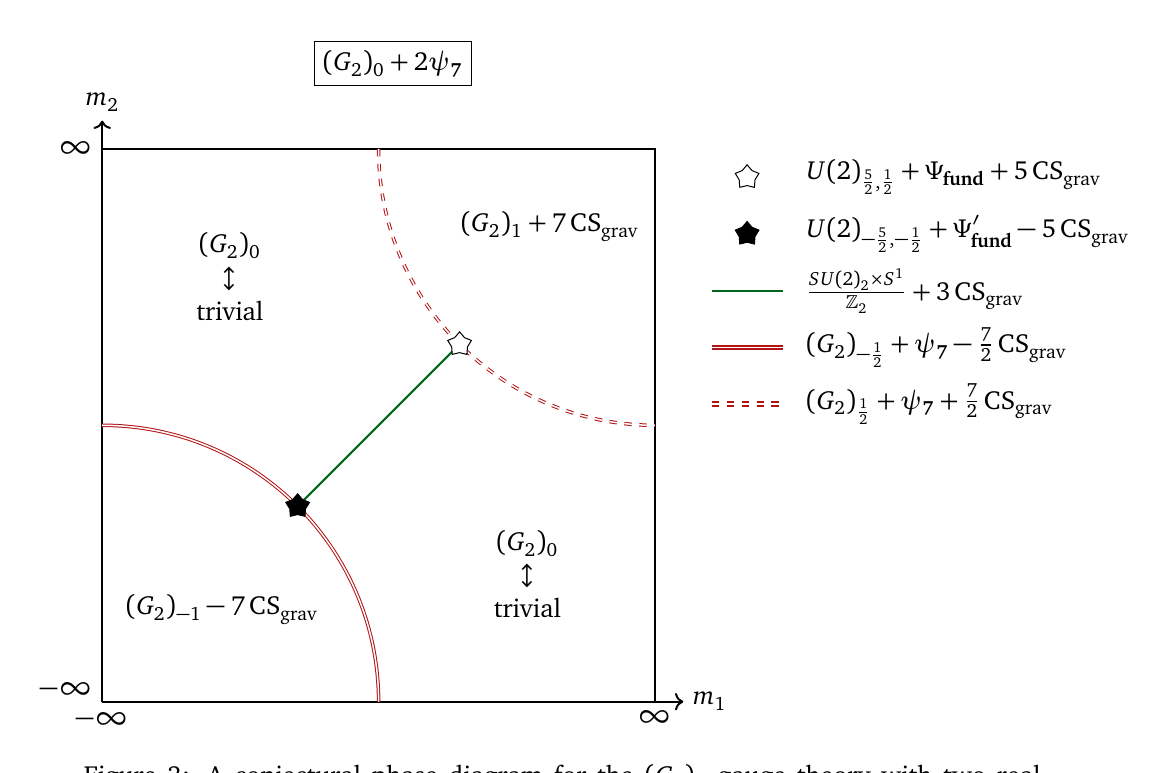
) Figure 3: A conjectural phase diagram for the ( G gauge theory with two real 2 0 fermions 2 ψ in the fundamental representation of G . The diagonal line where 7 2 = m m is identical to Figure 2. As explained there, on the solid line in the middle, 1 2 ( 2 ) × S 1 2 the theory flows to SU , and at the black and white stars the theory is dual to (cid:90) 2 + Ψ U ( 2 ) ± 5 . On the solid and dashed doubled lines we expect that the theory fund , ± 1 2 2 ) + ψ flows to a gapless theory dual to ( G , and intersects with the m ± 1 7 2 2 at the black and white